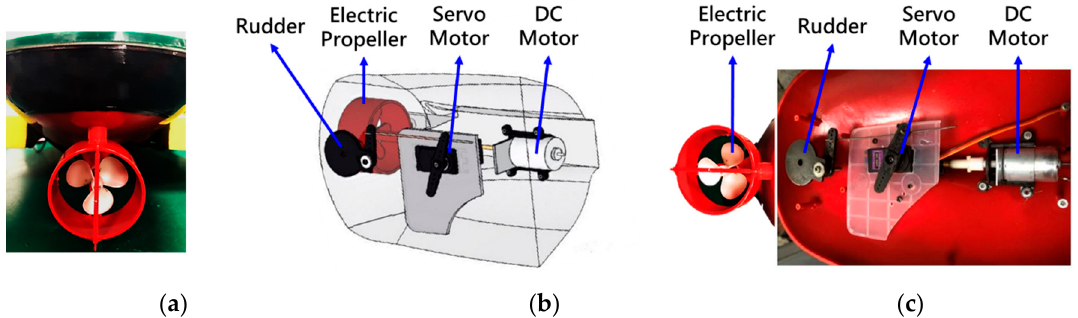
Figure 3. ( a ) Electric propeller and rudder. ( b ) Computer aided design (CAD) model of the locomotion module. ( c ) Locomotion module mounted on the MF-USV.